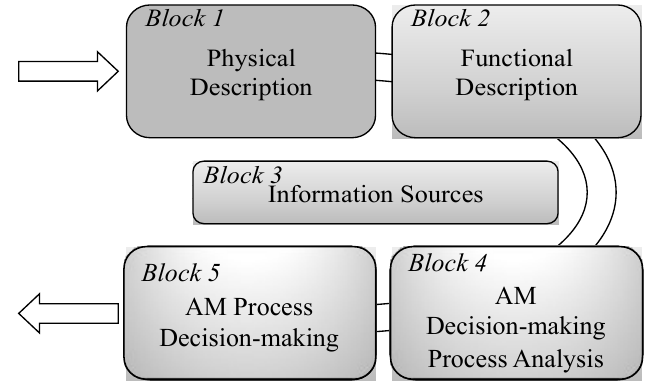
Figure 10. Generalization of the framework proposed by Guillen et al., (2016). Reproduced from [34], Computers in Industry: 2016.